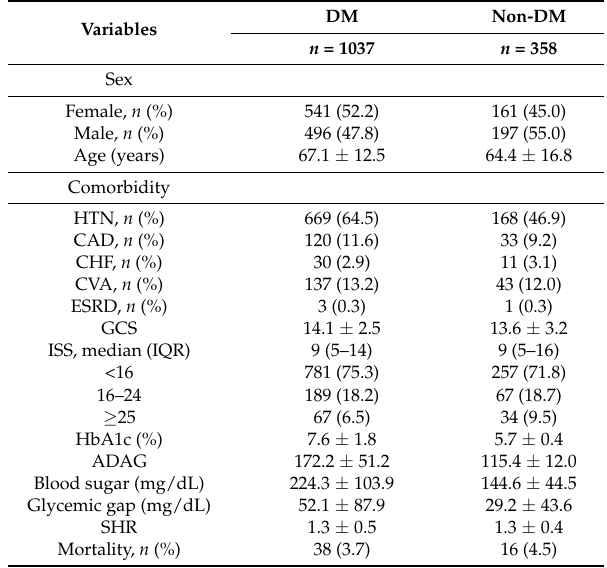
Table 1. Characteristics and glycemic variables of patients, with and without diabetes. DM Variables